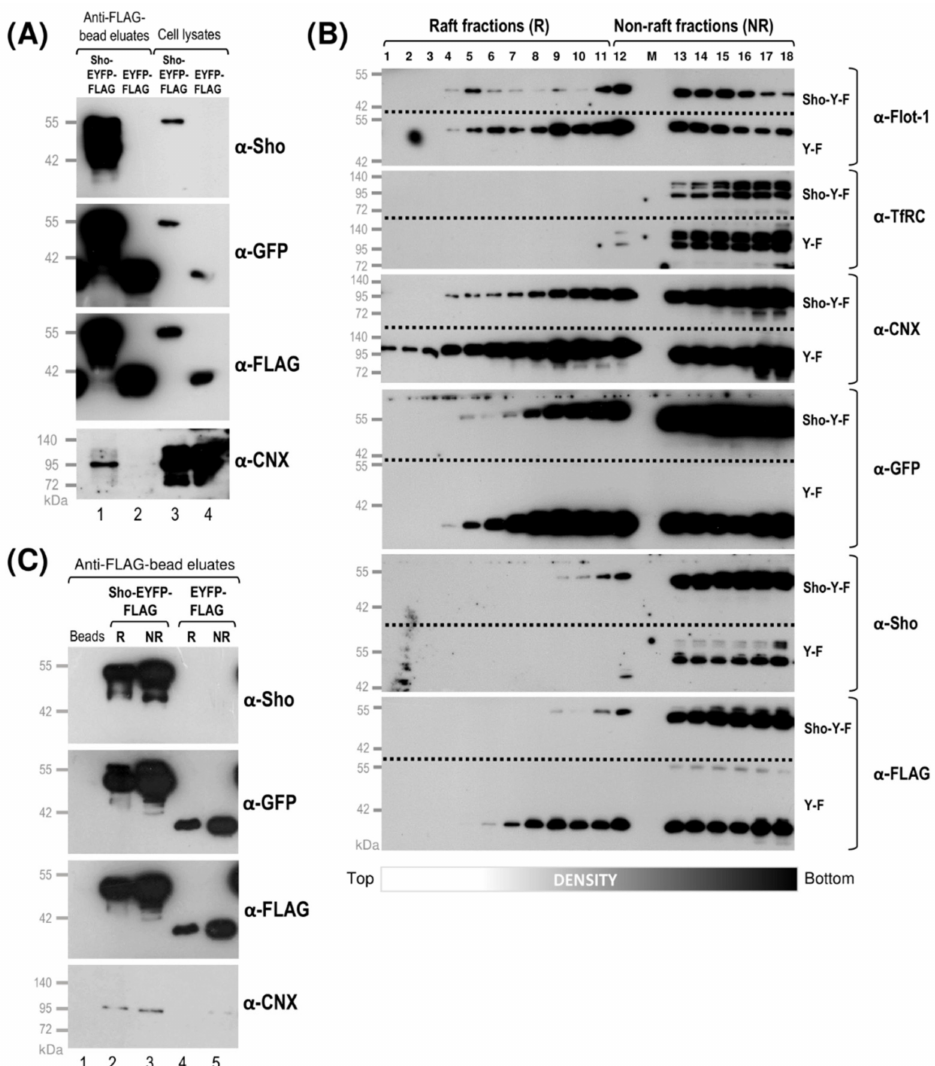
Figure 7. Calnexin is apparently a binding partner of Shadoo in both raft-and non-raft fractions. ( A ) Co-immunoprecipitation of Sho and CNX in unfractionated total cell lysates of Sho expressing Sho-EYFP-FLAG cells using anti-FLAG beads. Bead-pulled proteins (anti-FLAG bead eluates) are tested in parallel to the bead-input cell lysates loaded directly to the gel (cell lysate) by Western blotting for Sho (using α -Sho, α -FLAG and α -GFP antibodies) and for CNX (using α -CNX antibody). Beads treated similarly but without the applied sample are used as a negative control (beads). The molecular weight ladder is indicated on the left side. ( B ) Western blot analysis of the fractions resulting from the OptiPrep density-gradient fractionation of Sho-EYFP-FLAG (marked as Sho-Y-F) and of its control EYFP-FLAG (marked as Y-F) cells. Following SDS-PAGE, the gels corresponding to the two types of cells are cut and arranged one below the other prior to performing a transfer onto the same PVDF-membranes, allowing side-by-side testing for the proteins marked using the antibodies as follows: α -Sho, α -FLAG and α -GFP antibodies for Shadoo; α -CNX for calnexin; and α -flottilin-1 ( α -Flot-1) for flotillin-1, and α -TfRC for transferrin receptor. The fraction numbers are indicated on the top, and the raft and non-raft regions are marked. ( C ) Co-immunoprecipitation of Shadoo and calnexin proteins from the density-gradient-separated fractions. Equal amounts of pooled fractions belonging to either raft (R) or non-raft (NR) fractions (as marked on ( B )) of Sho-EYFP-FLAG or control EYFP-FLAG cells are loaded onto anti-FLAG beads, and the bead-pulled proteins are tested in parallel by Western blotting for Sho and CNX by the same antibodies as in ( B ). All gels used are 10% PA SDS